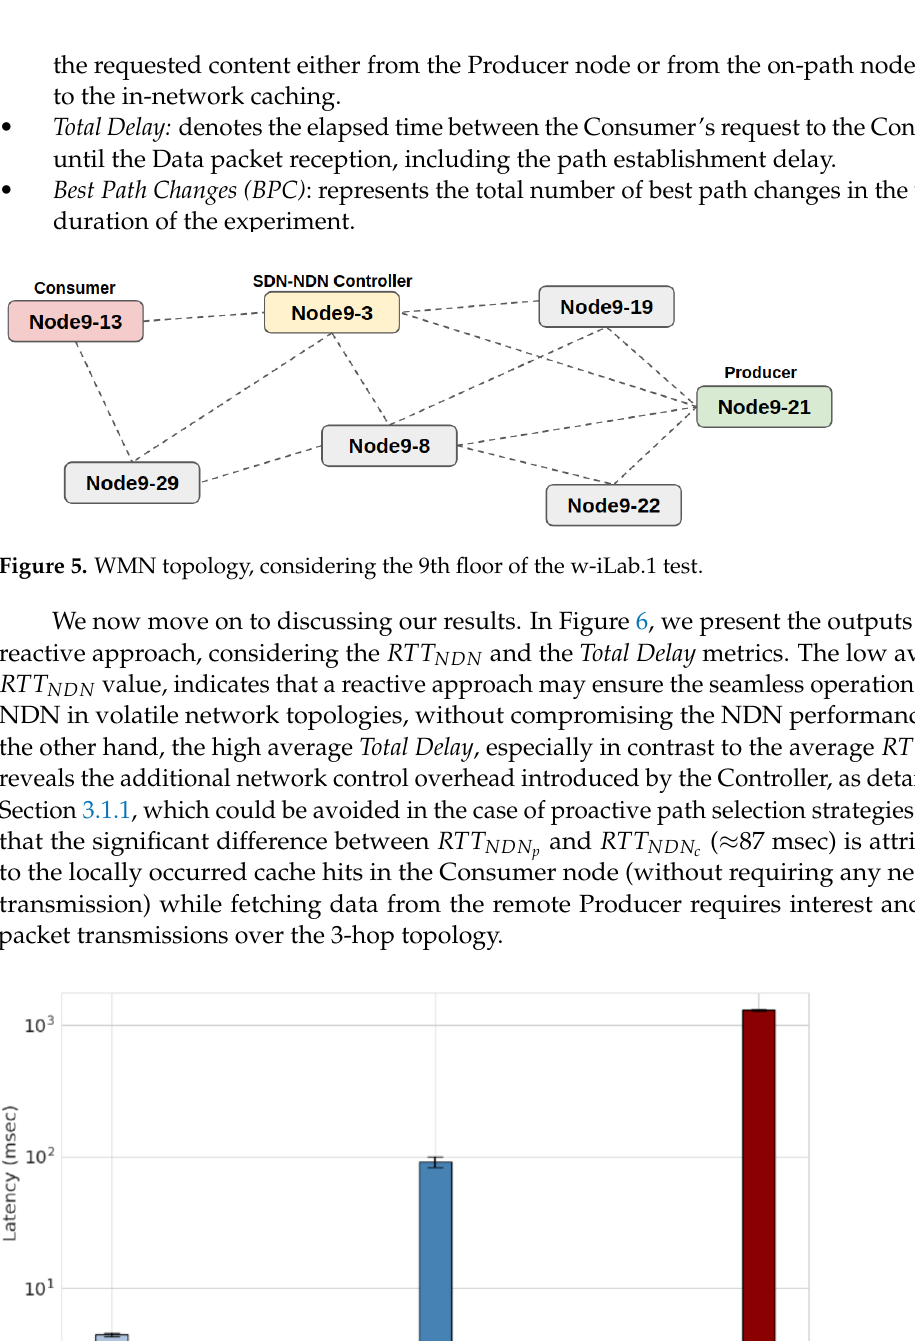
, RTT NDN and Total Delay c p